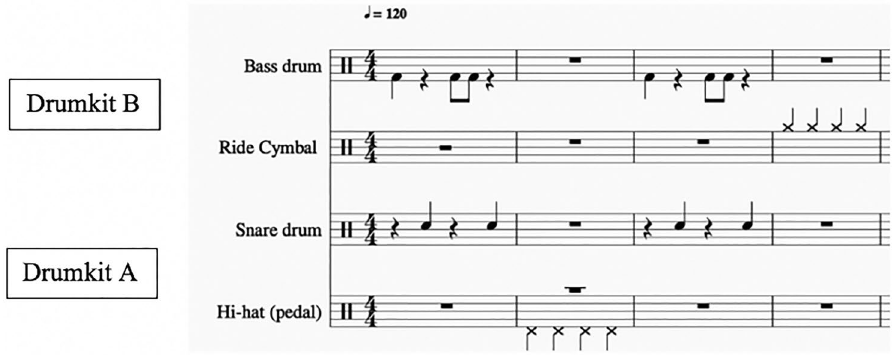
Figure 1. Drum pattern (stimulus 1). The score was generated with the notation software MuseScore (www. muses core. org, version 2).